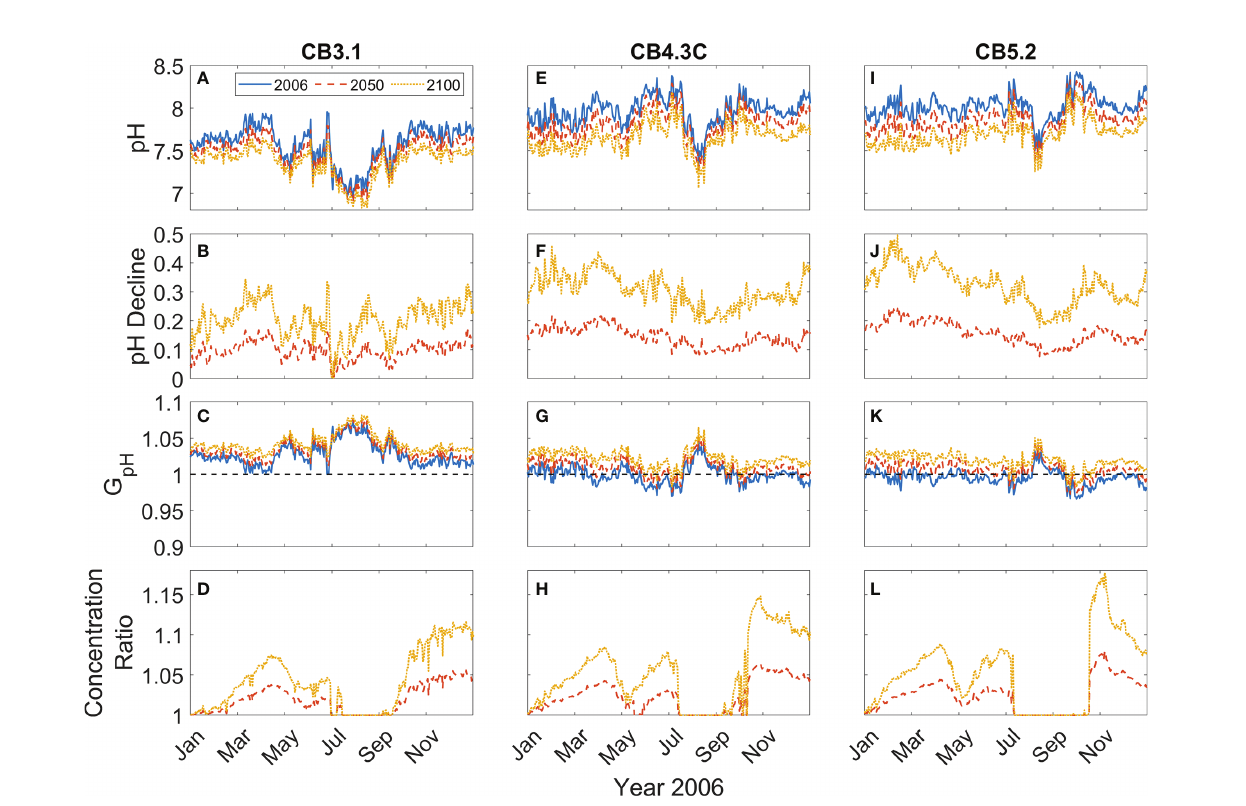
FIGURE 7 | Time series of daily surface pH (A, E, I) , pH decline (B, F, J) , GpH (C, G, K) , and ratio of P. minimum concentration in mid-21st century and late-21st century to that in year 2006 (D, H, L) at 3 mainstem stations marked in Figure 2A